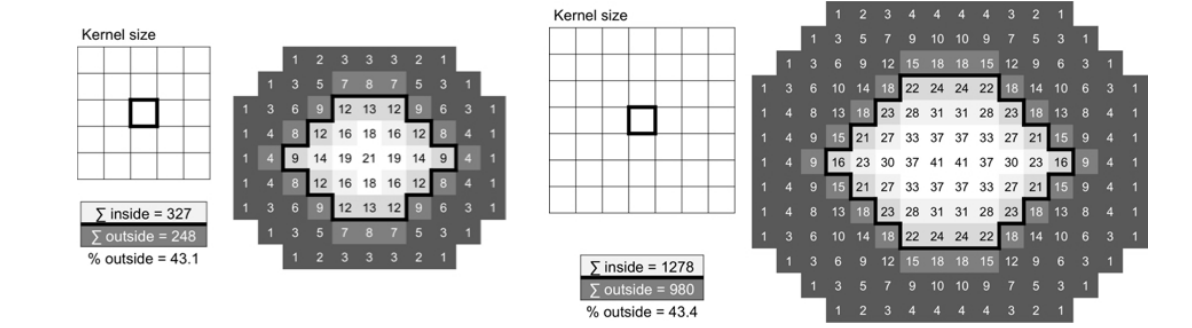
Fig. 4 . Typical pixel dimensions of a Lesser Snow Goose ( Chen caerulescens caerulescens ) object following segmentation of 5-cm (left) and 4-cm (right) resolution aerial imagery, showing the surrounding area included in object texture calculations when using a kernel size of 5 x 5 pixels and 7 x 7 pixels, respectively. The values assigned to the pixels represent the cumulative number of times each pixel is sampled by the kernel when applied to every pixel inside the object in the process of calculating texture attributes. With the total number of times outside pixels are sampled approaching the number of times inside pixels are sampled, the magnitude of contrast between birds and background is strongly reflected in the texture range and variance attributes.